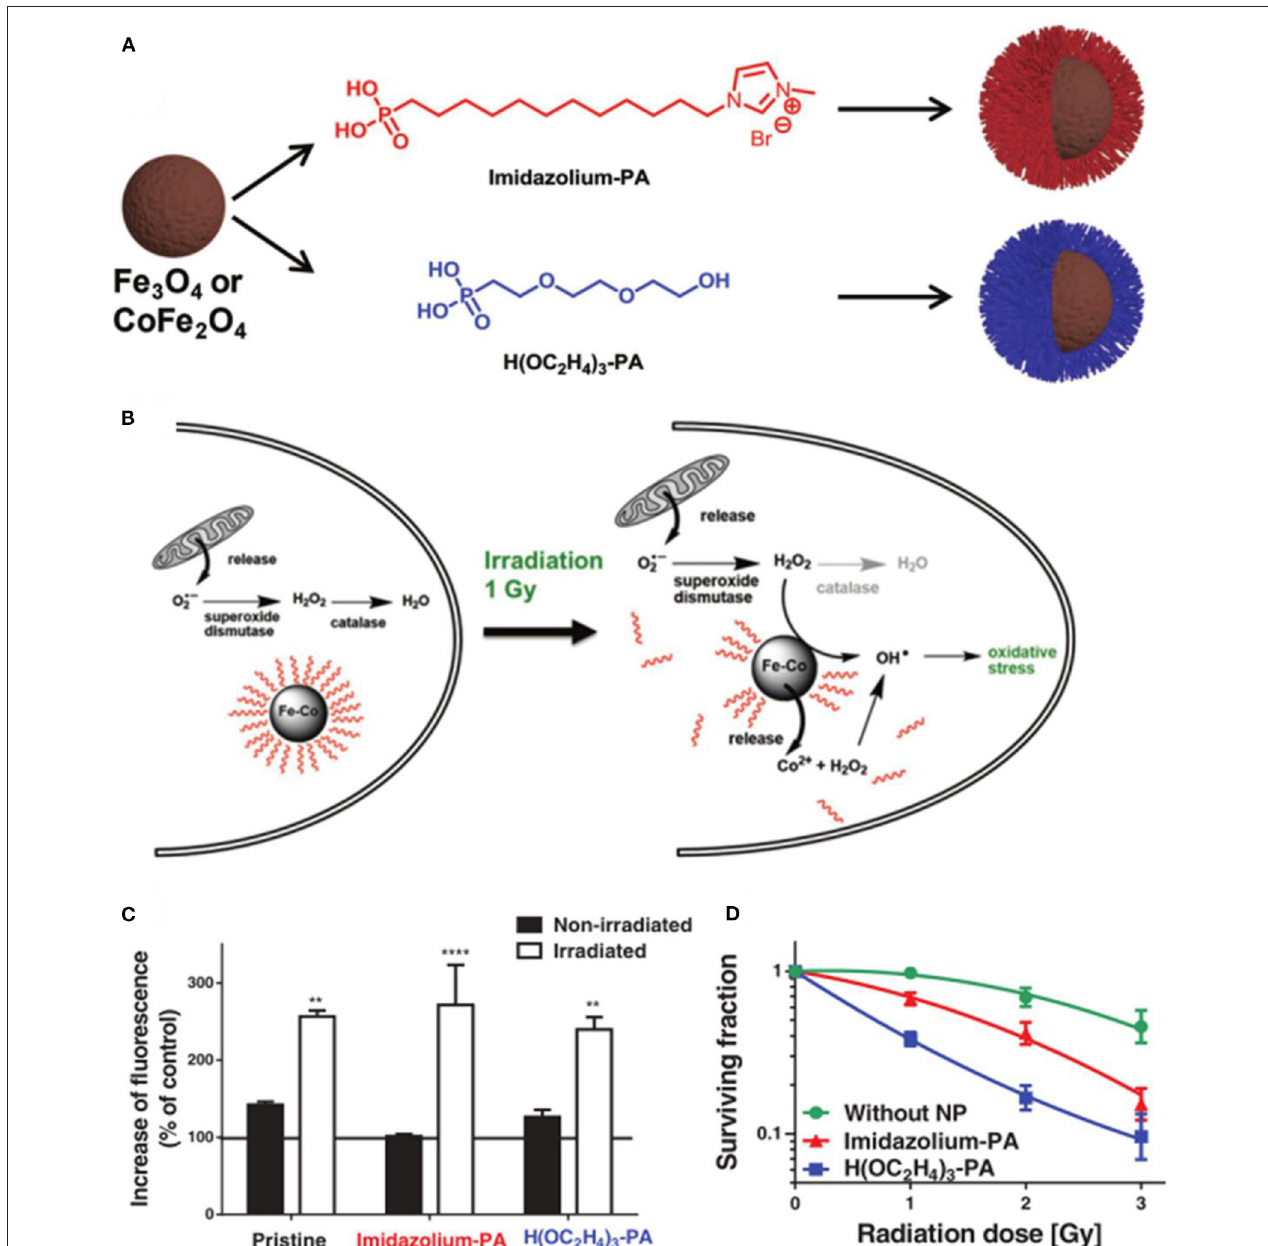
FIGURE 7 | (A) Fabrication of PA-SAM functionalized Fe 3 O 4 and CoFe 2 O 4 MNPs. (B) Mechanisms of ROS generation under X-ray irradiation. (C) Determination of ROS concentration in MCF-7 cells. (D) Survival curves of MCF-7 cells incubated with functionalized CoFe 2 O 4 MNPs. ** P < 0.01,**** P < 0.001. Reproduced,